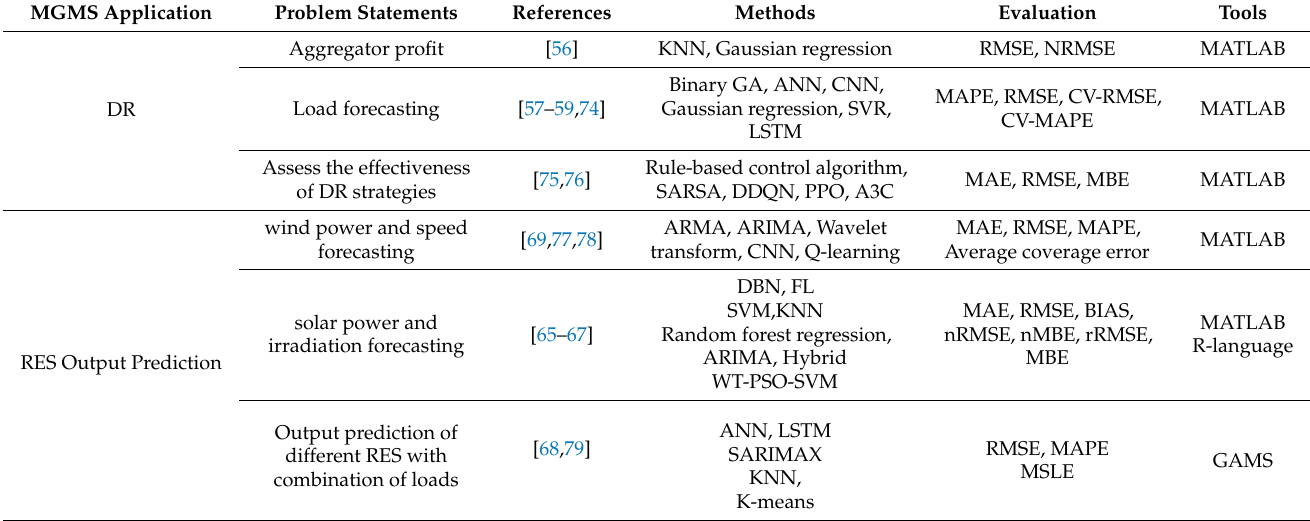
Table 2. Related work objective